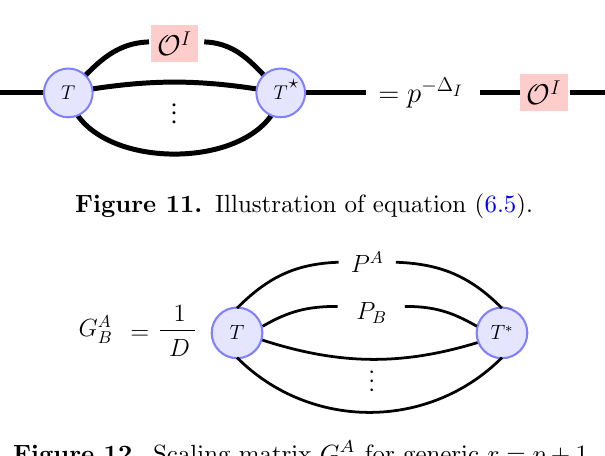
for generic r = p + B